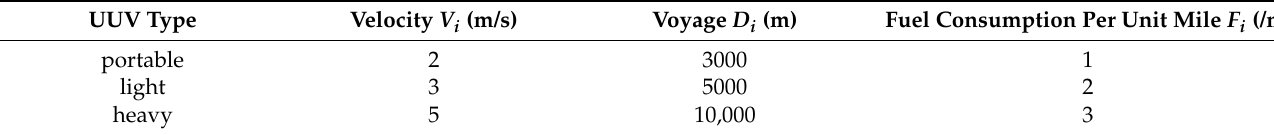
Table 2. UUV parameters.